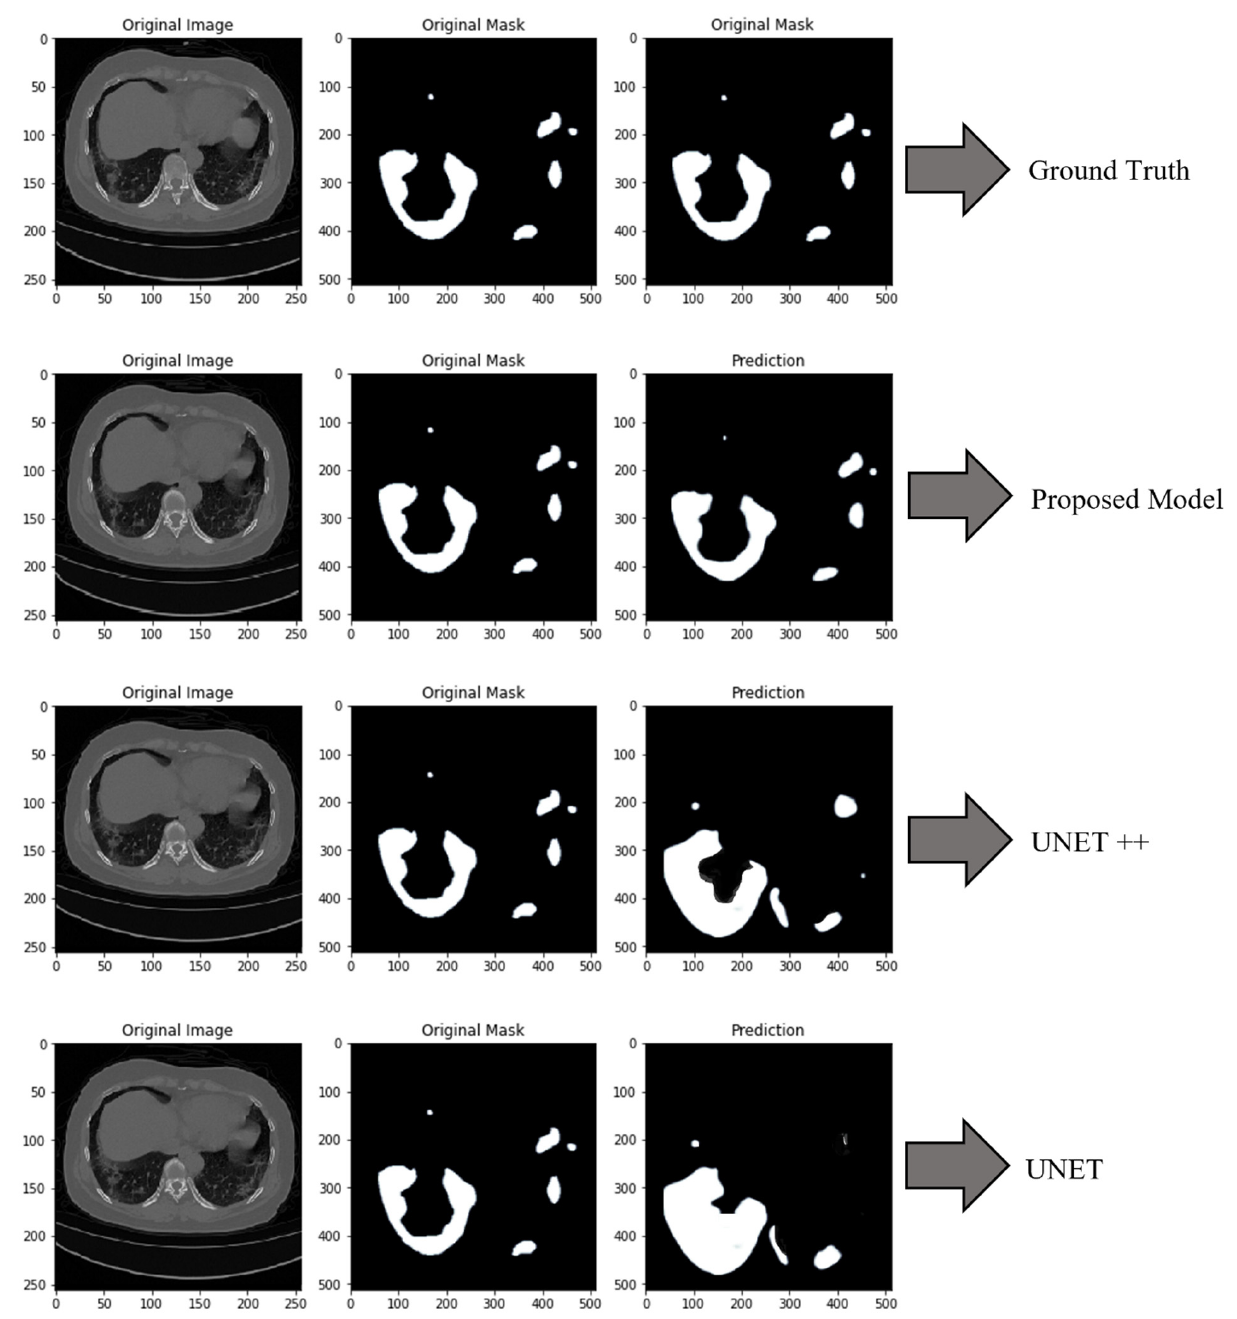
Figure 8. Segmentation of COVID-19 infected CT scan. The first row represents the ground truth portion of the COVID-19-infected patients. The second row presents the prediction made by the proposed model about the infected area. In the third and fourth row are presented the results produced by the UNET++ and UNET, respectively.